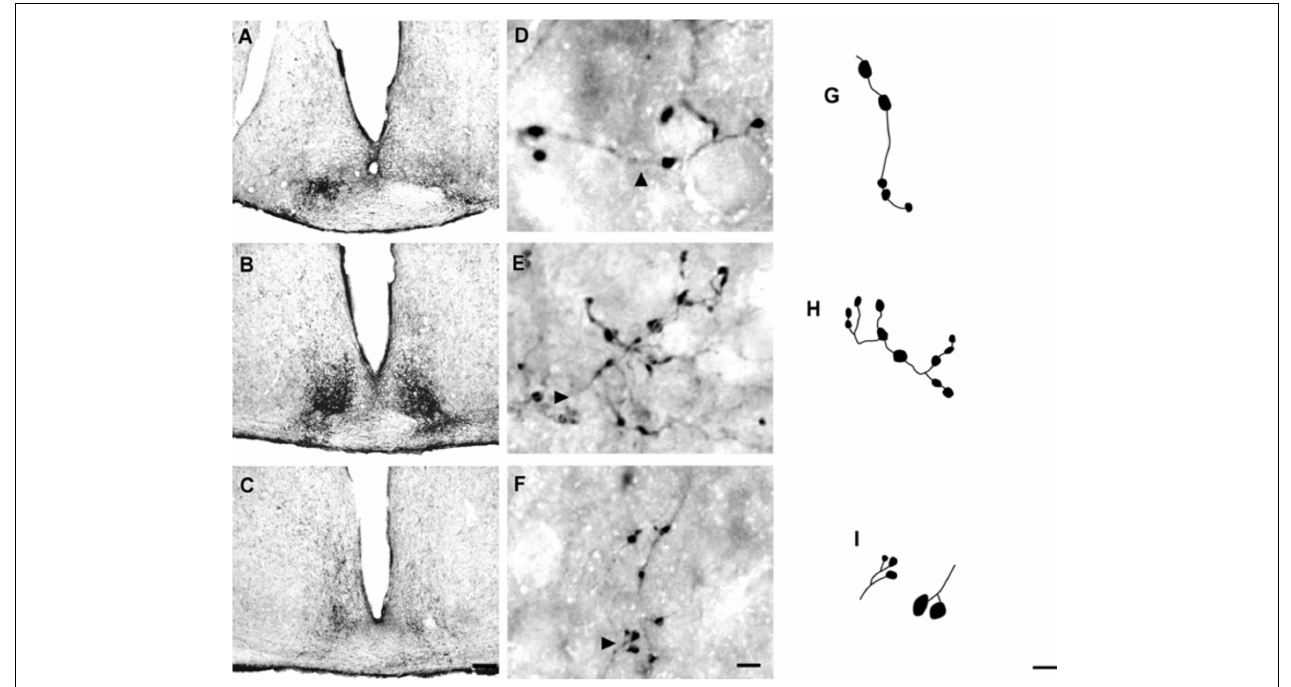
FIGURE 2 | Photomicrographs of the SCN coronal sections of flat-faced fruit-eating bat at rostral (A) , middle (B) and caudal (C) levels, illustrating the distribution pattern of retinal projections in the ipsi and contralateral sides. The boxed areas in (A–C) are shown in high magnification in (D–F) , respectively, illustrating the detailed morphology of the retinal axons in the SCN showing cholera toxin-labeled varicosities in the simple endings (D) , string-like terminals (E) and R2-like terminals (F) . Black arrowheads point to sort of fibers. (G–I) Camera-lucida drawings that depict the morphology of simple endings (G) ; string-like terminals (H) and R2-like terminals (I) . Scale bar 100 µ m (A–C) and 10 µ m (D–I)